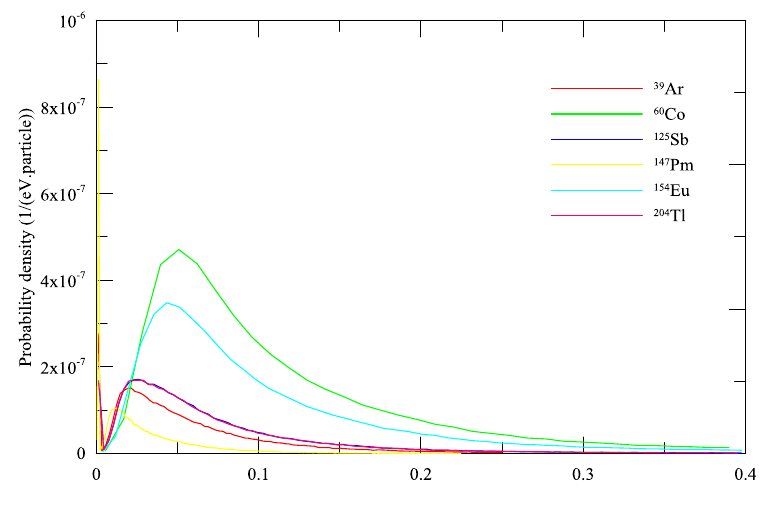
Fig.9: The backscattered photons spectrums produced by absorption of target nuclei ( 39 Ar, 60 Co, 125 Sb, 147 Pm, 154 Eu, and 204 Tl) beta particles into silicon